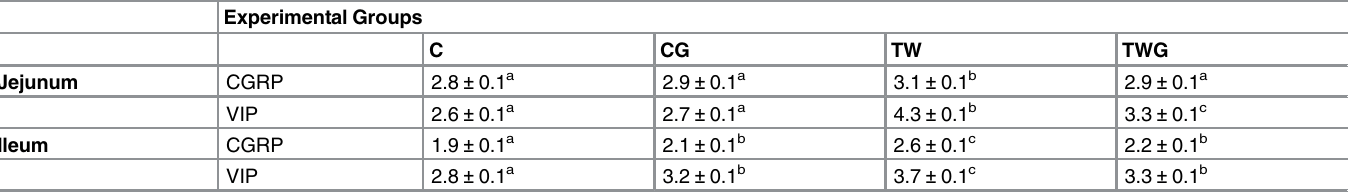
Table 8. Morphometric analysis of VIP-immunoreactive and CGRP-immunoreactive varicosities areas ( μ m 2 ) in the myenteric plexus in the intesti- nal regions (jejunum and Ileum). Experimental groups: control (C); control supplemented with 2% L-glutamine (CG); Walker-256 tumor (TW); and Walker- 256 tumor supplemented with 2% L-glutamine (TWG).